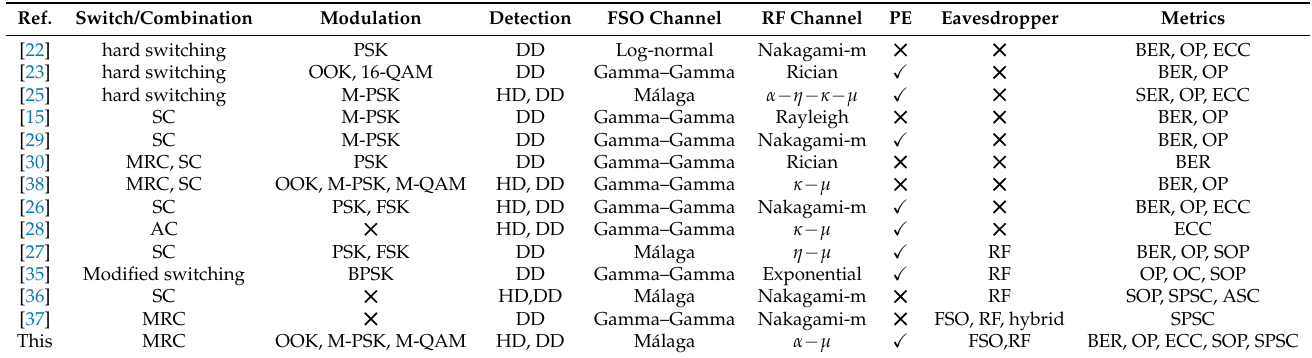
Table 1. Comparison of research contents between the relevant literature and this paper on the hybrid FSO/RF parallel transmission